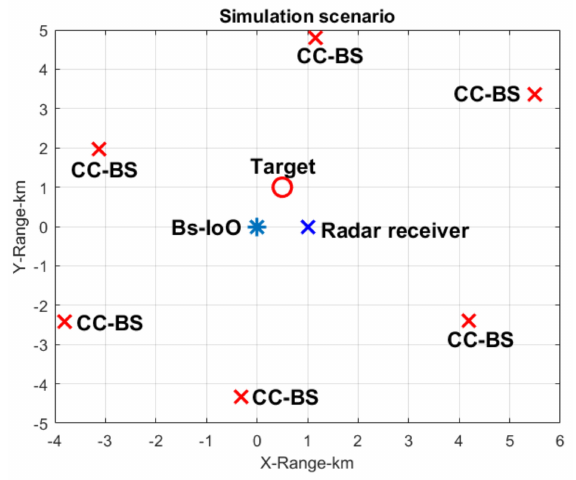
Figure 8. Simulation scenario.